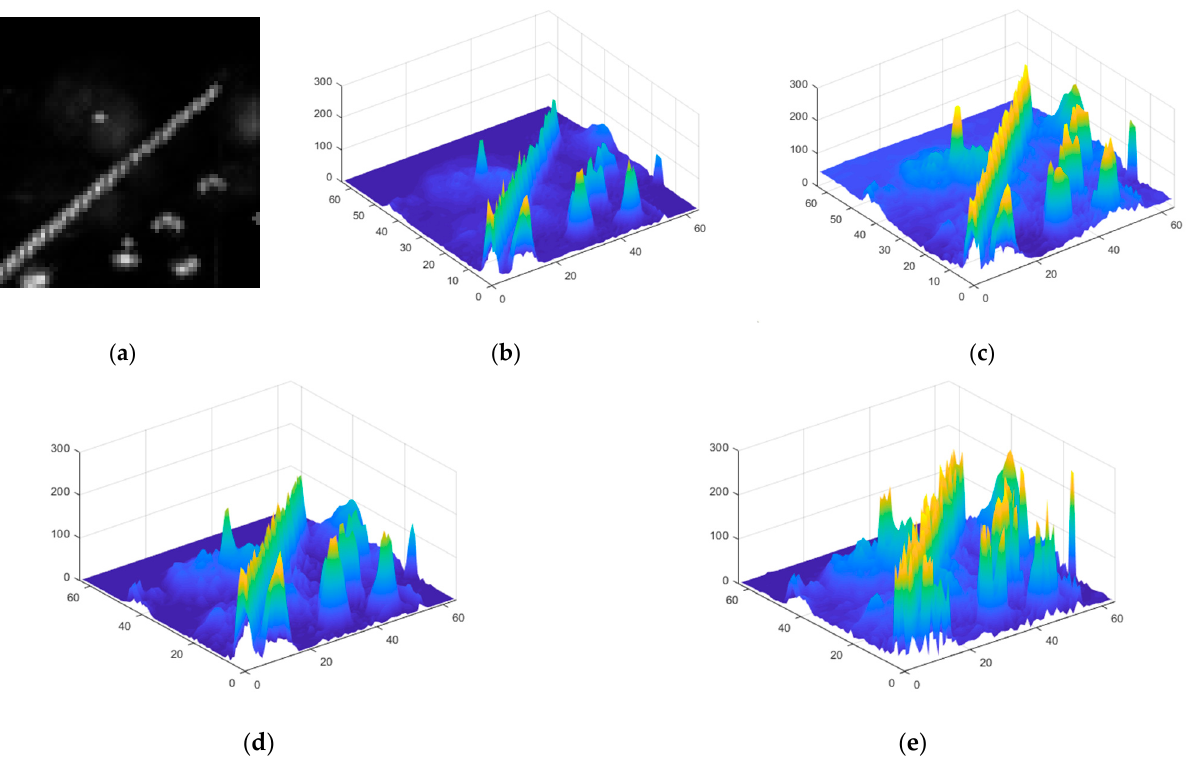
Figure 4. Intensity image-enhanced 3D visualization results: ( a ) 2D intensity image; ( b ) 2D intensity image; ( c ) 3D results enhanced by the ACE method; ( d ) 3D results enhanced by the ACE method; ( e ) 3D results enhanced by the linear transformation method.